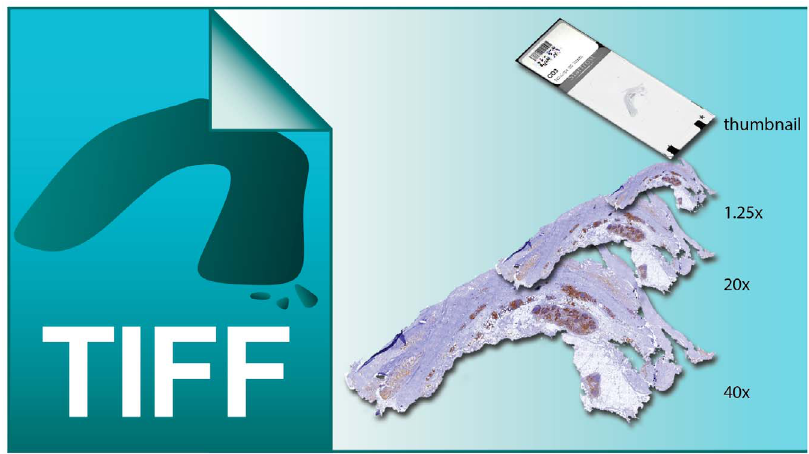
Figure 2. A visualisation of a multi-page pyramid TIFF file. This illustration shows a TIFF file with 4 layers (thumbnail, 1.25x, 20x, 40x), digital slides stored as TIFF files often contain up to 11 or more layers.